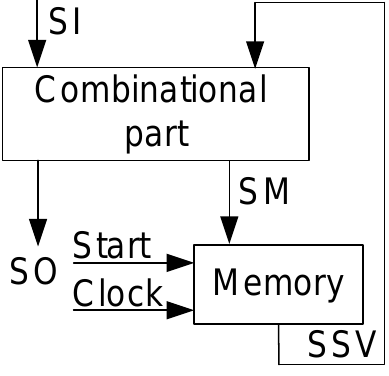
Figure 2. Structural diagram of Mealy FSM A 1